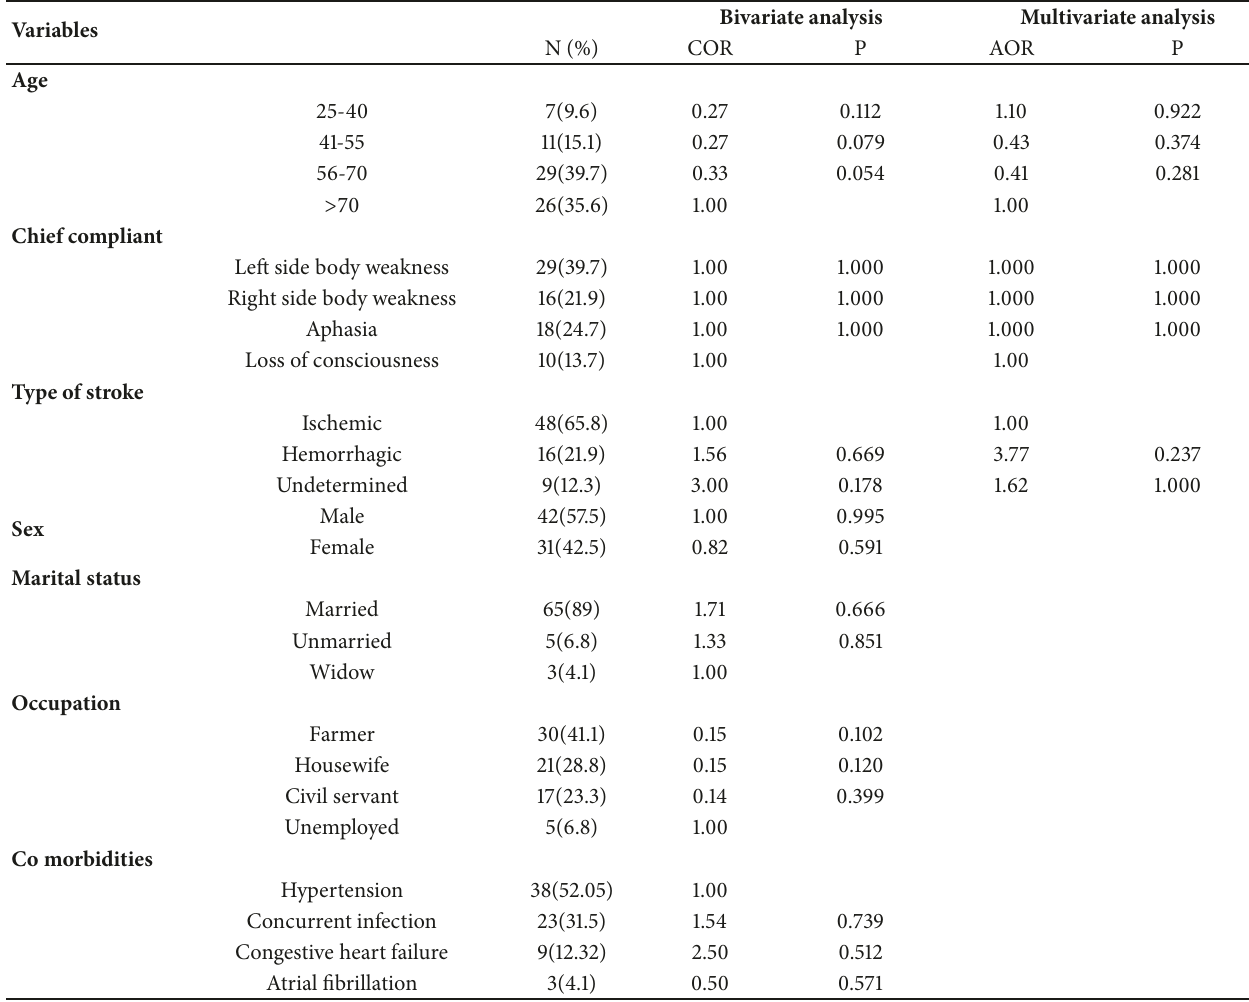
Table 1: Sociodemographic and clinical characteristics of hospitalized stroke patients at Shashemene Referral Hospital, 2012–2017 (N=73).